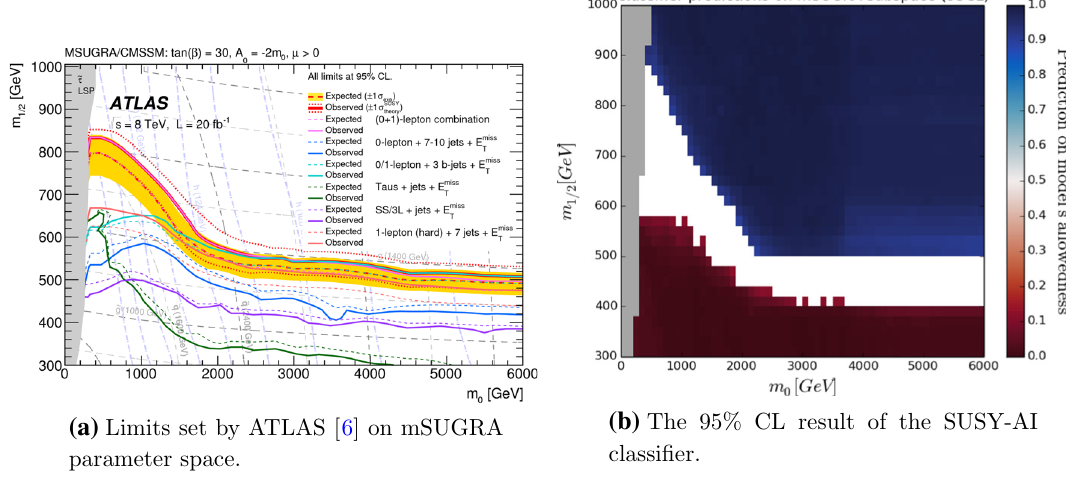
Fig. 10 Results of testing cMSSM with the trained classifier. The colors in b indicate the probability of the single point not being excluded. The white band in b corresponds to the points that were outside the 95% CL